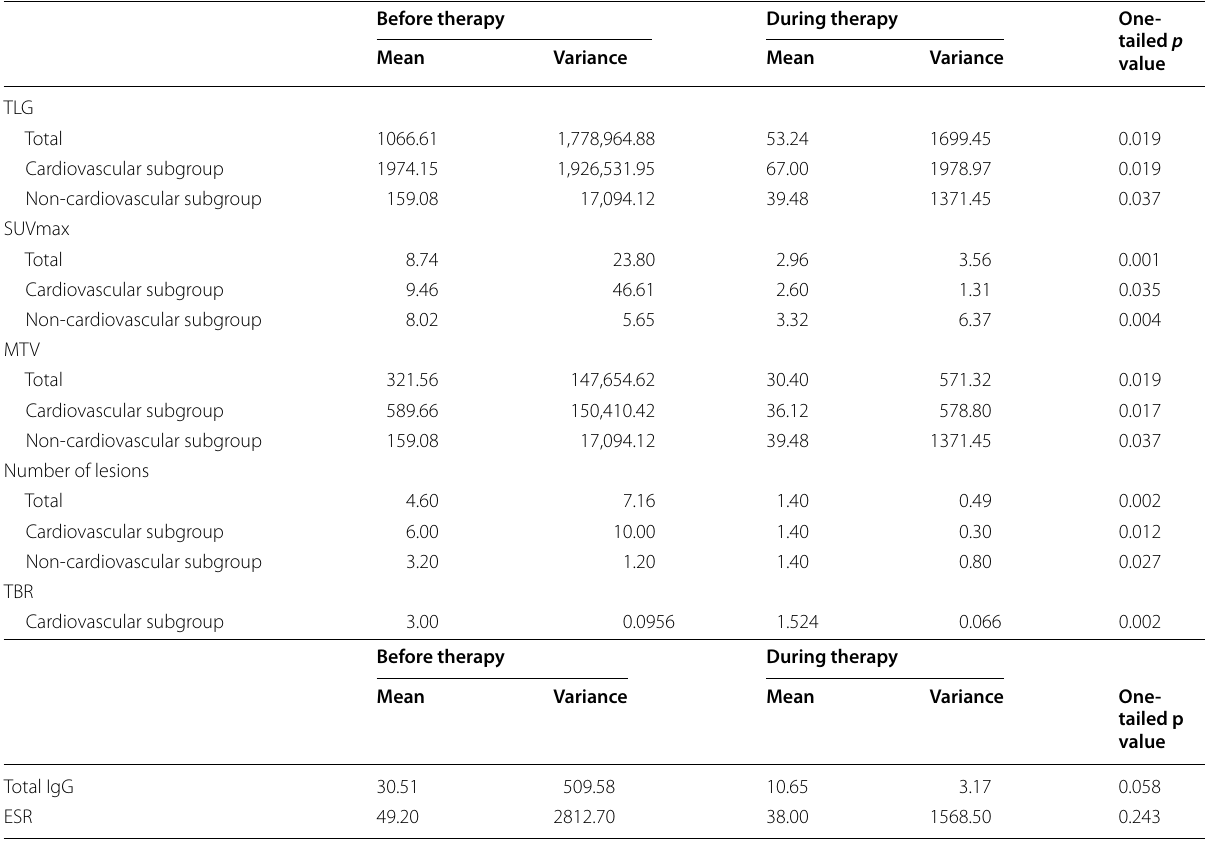
Out of 10 patients with pre-treatment and post-treatment 2-[ 18 F]FDG PET/CT scans, there were significant decreases in TLG, SUVmax, MTV, and number of lesions, but no significant decrease in total IgG and ESR. There was also statistically significant difference in TBR for the cardiovascular subgroup